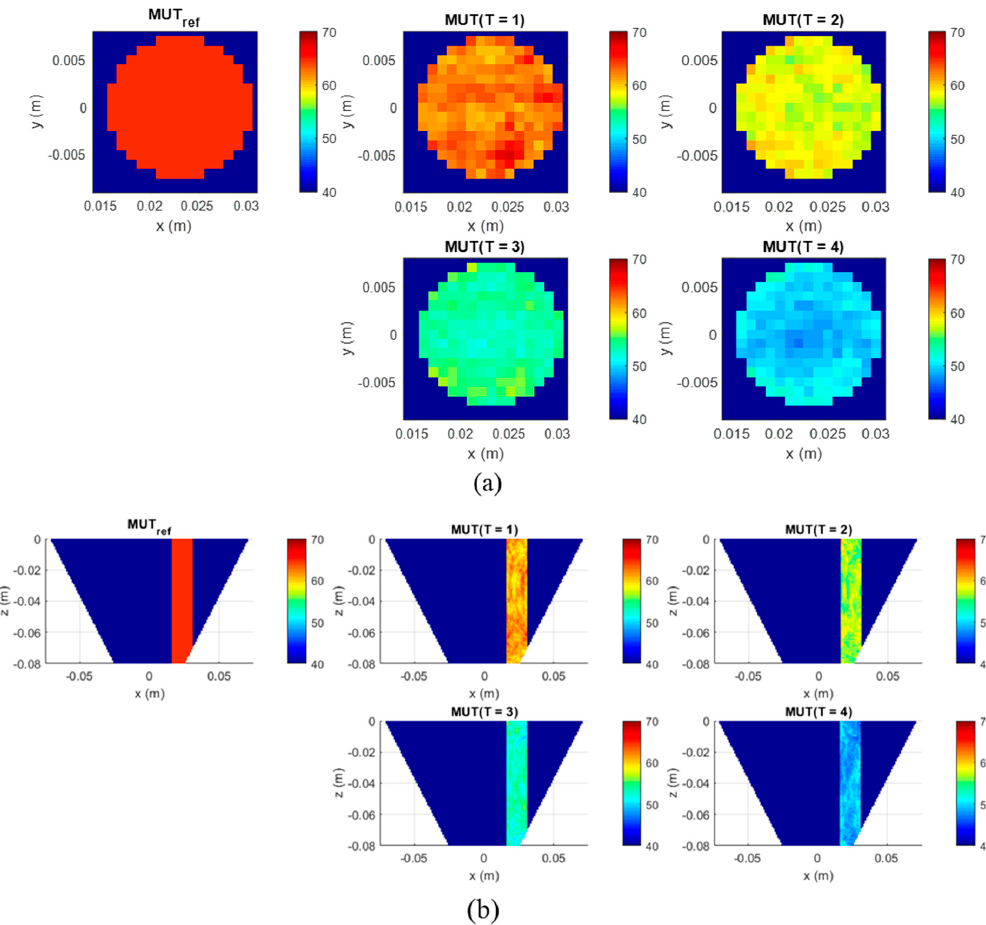
Figure 7. Distribution of the estimated relative permittivity ˆ ε t ( r 0 , ω , T ) at 2 GHz based on Equation (10) in the tumor area ( a ) in xy-slice, depth z = − 2 cm and ( b ) in xz-slice, y = 0. Color bar represents the relative permittivity value. The numerical distribution of the values of estimated relative permittivity in the 3D imaging domain is presented in Figure 8. The data show a nearly symmetric distribution.